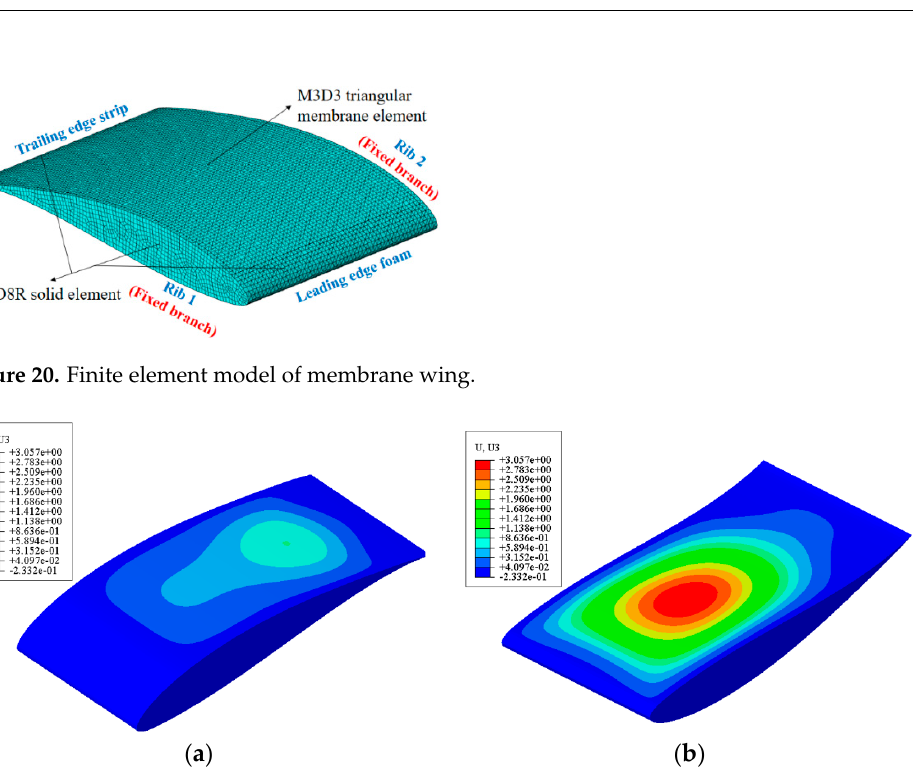
Figure 22. Numerical simulation of lift characteristics of rigid-/polyimide-skin wing: ( a ) v = 6.4 m/s; ( b ) v = 9.0 m/s; ( c ) v = 11.0 m/s. Figure 23 can visually portray the increment of aerodynamic coefficient caused by membrane deformation under different inflow conditions. In the figure, Δ C L , Δ C D , and